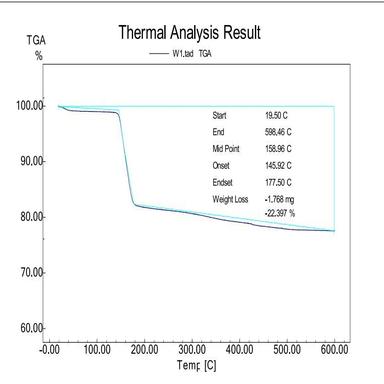
Thermogravimetric analysis of sample.